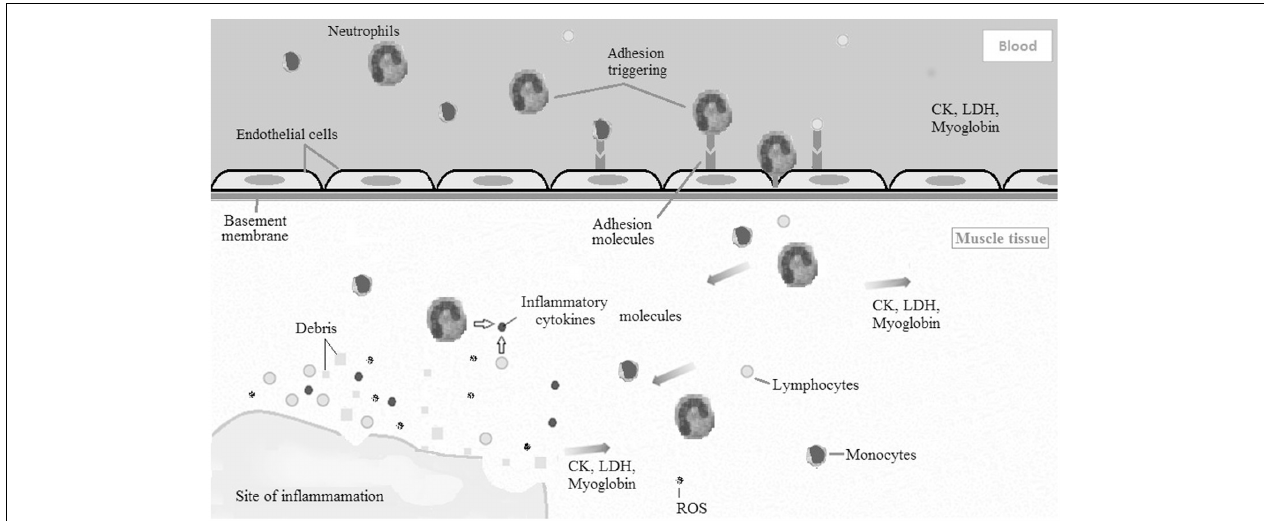
FIGURE 1 | Diagram illustrating the acute inflammatory process caused by exercise induced muscle damage (EIMD). Leukocytes (neutrophils, monocytes, and lymphocytes) are mobilized to the damaged muscle tissue via soluble intercellular adhesion molecule 1 (sICAM-1). Afterward, pro-inflammatory cytokines and reactive oxygen